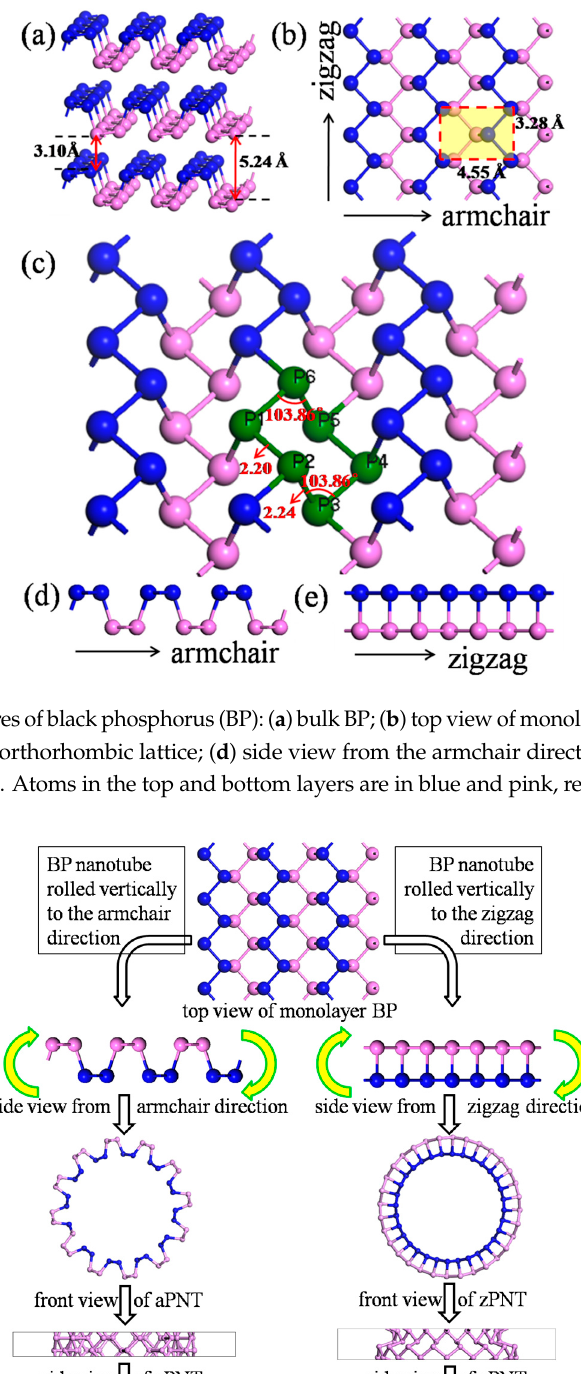
Figure 2. Schematic diagram of the construction of BP nanotubes.